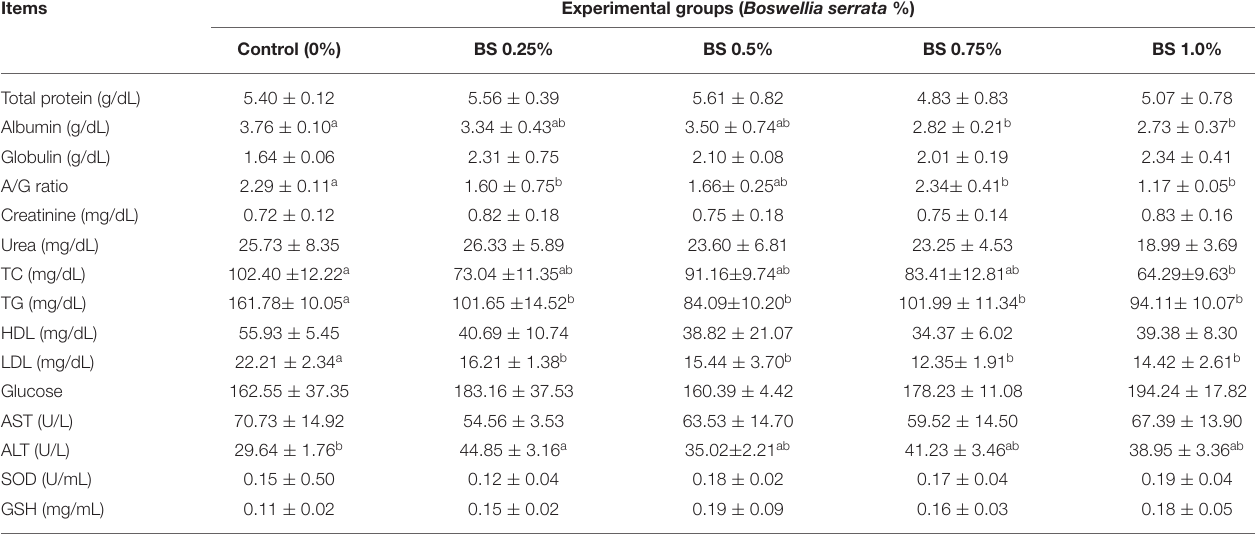
TABLE 5 | Effects of Boswellia serrata on serum metabolites of NZW rabbits. Items